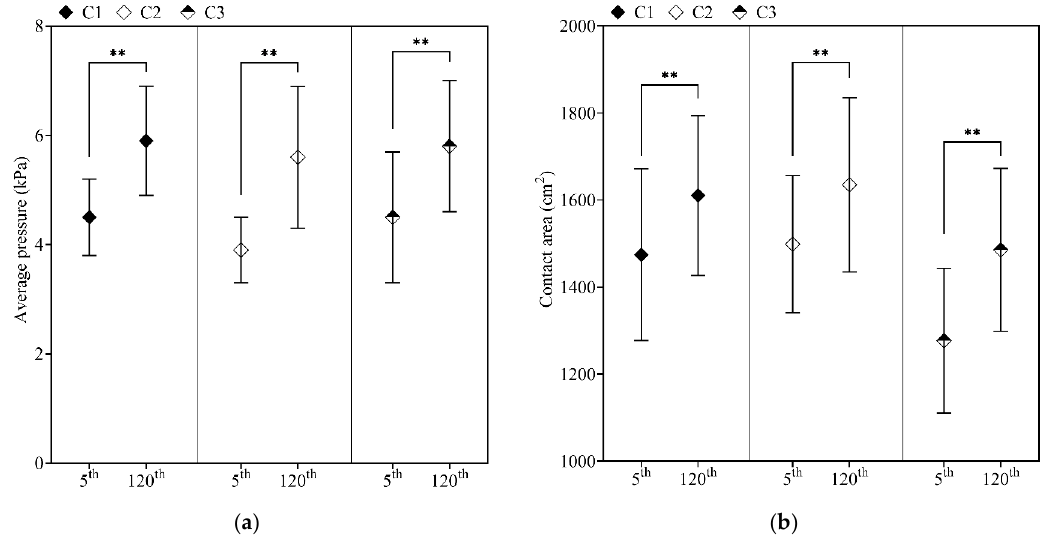
Figure 2. Illustration of the preferred driving postures between the subgroups at the initial and final recording. Note. C1— Cluster 1; C2—Cluster 2; C3—Cluster 3. ( a ) 5th minute of steering; ( b ) 120th minute of steering.